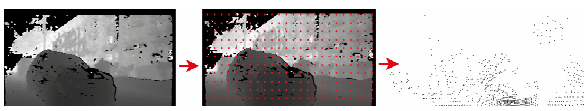
Figure 2 . Preparation of a point cloud. Depth map is smoothed, if necessary, specific points are selected and transformed via interior camera geometry and depth values into 3D points.